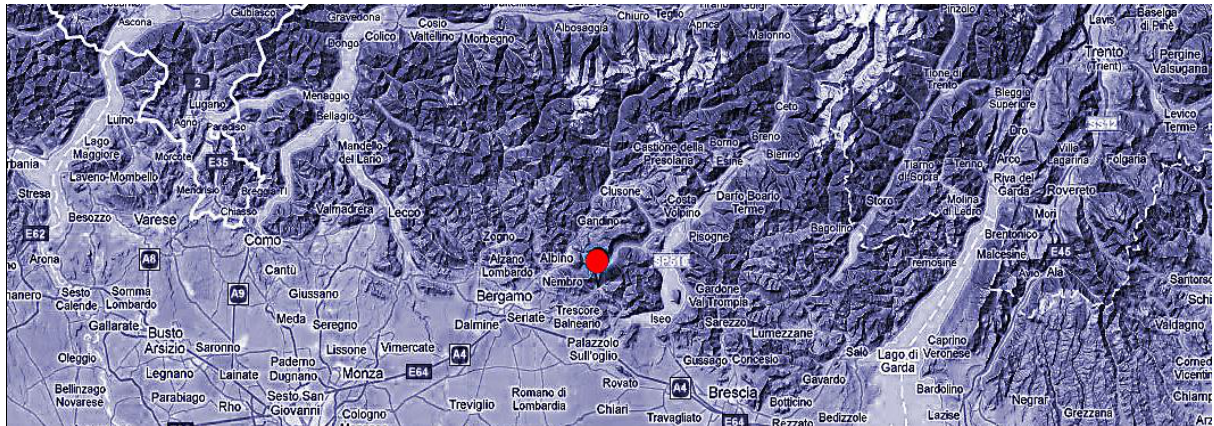
Figure 00. Case studies: Church of Maria Assunta e San Michele Arcangelo in the town of Borgo di